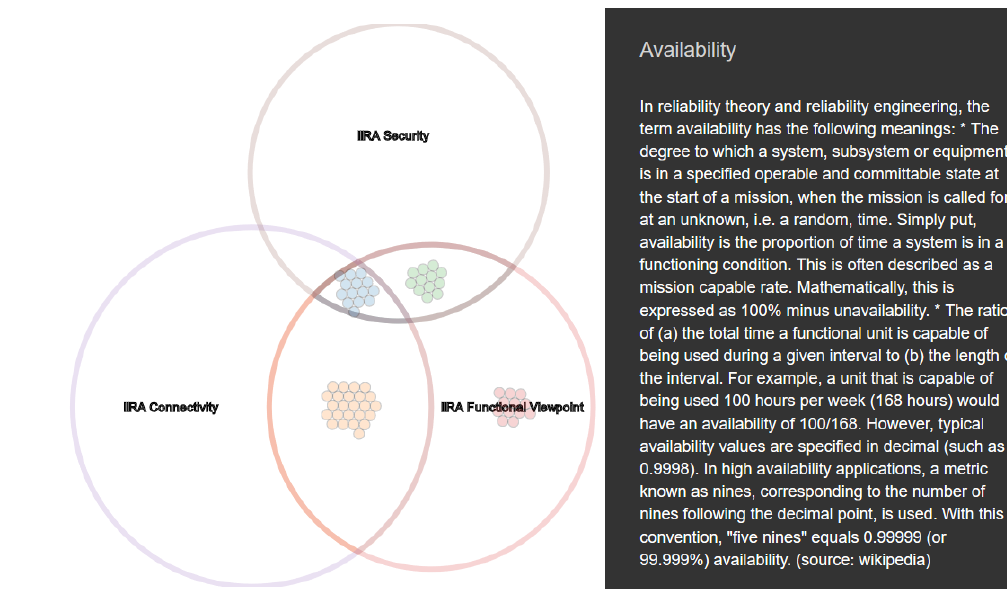
Figure 5. Concerns as framed by the IIRA sections on connectivity and security (http://i40.semantic-